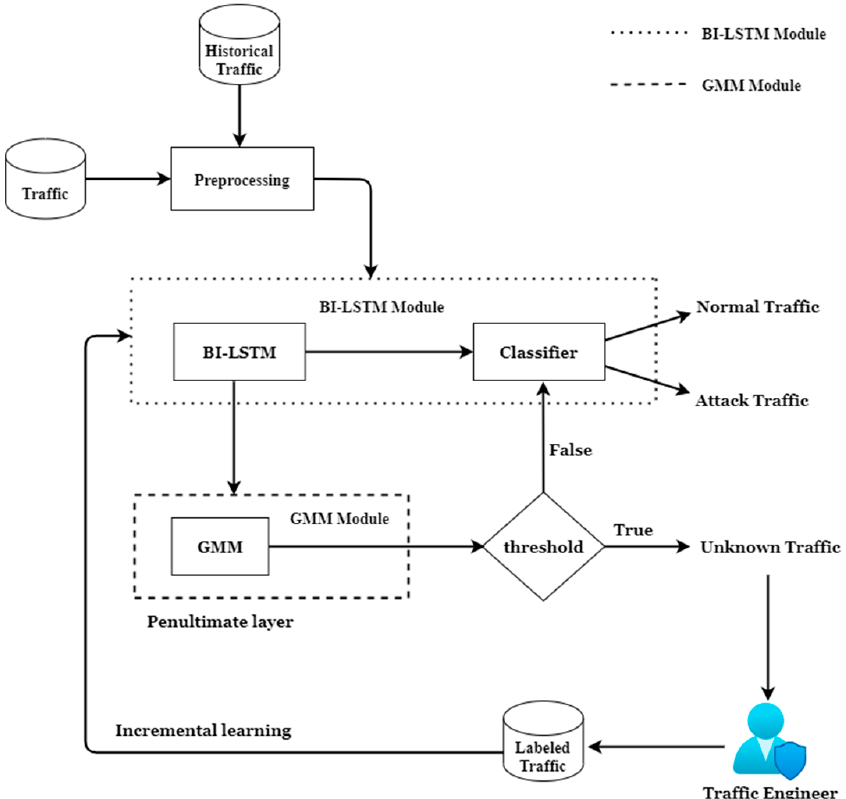
Figure 2. The functional block diagram of the proposed BI-LSTM-GMM.